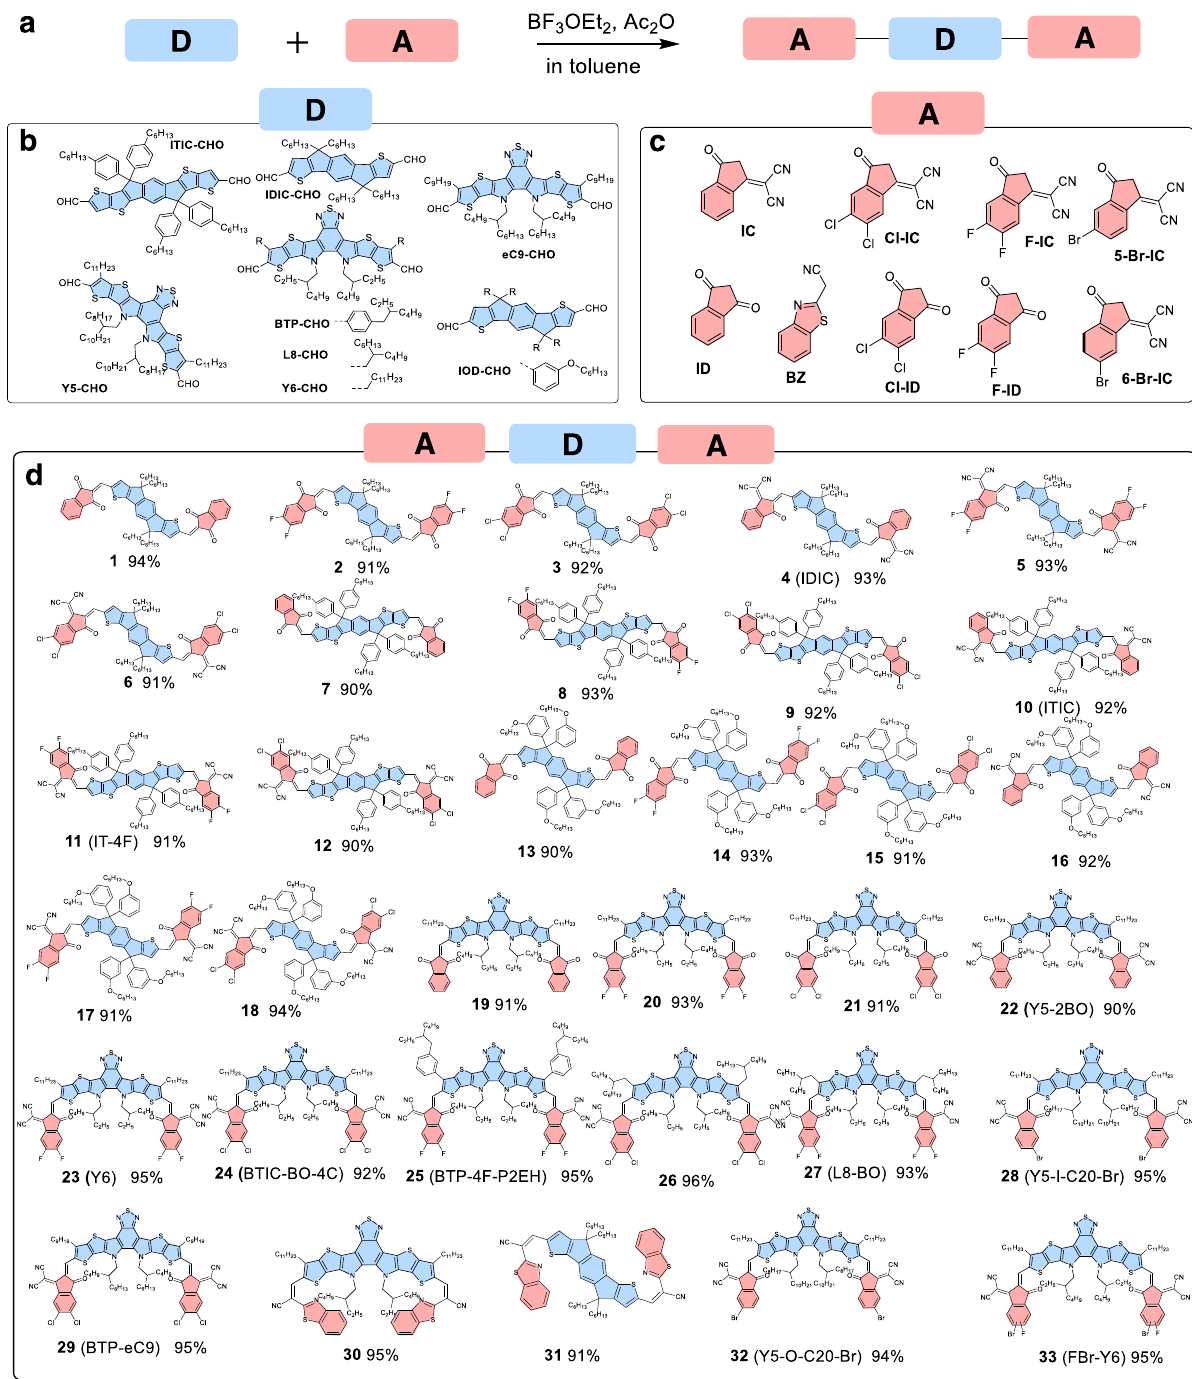
Fig. 3 Chemical structures and synthetic routes. a The synthetic route for SMAs; b The aldehyde-terminated D groups; c The end-capping A groups; d Chemical structures of SMAs generated with isolated yields. To simplify, here the D-units represent aromatic-fused-ring D or DA ’ D-core. In the molecules, the bule color represents D unit and the red color represents the A unit. For the reported SMAs, the abbreviations of their name are given in the